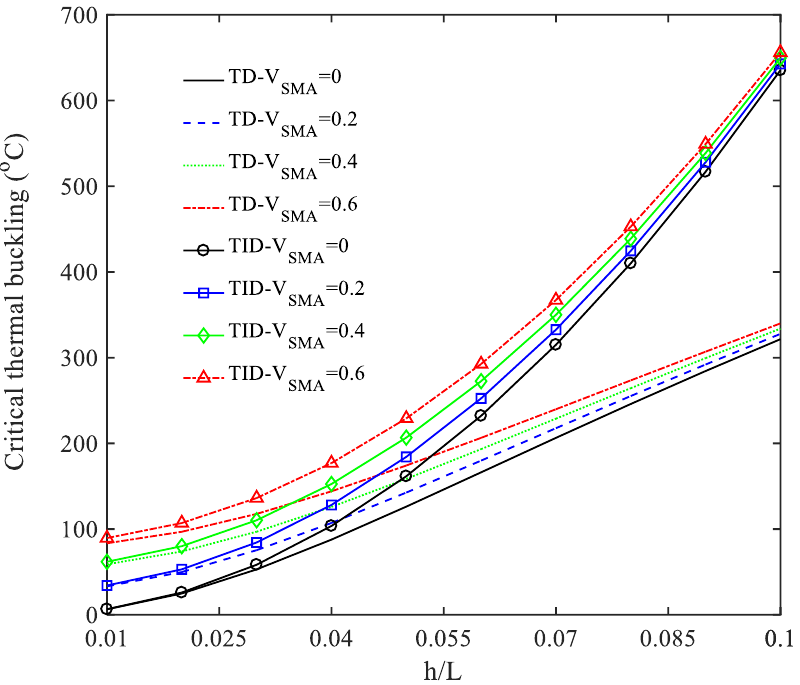
Figure 4. Variation of the critical thermal loading vs. h / L for TD and TID properties and different values of V SMA ( n = 1, h c / h = 0.8 and ε 0 = 2% ).